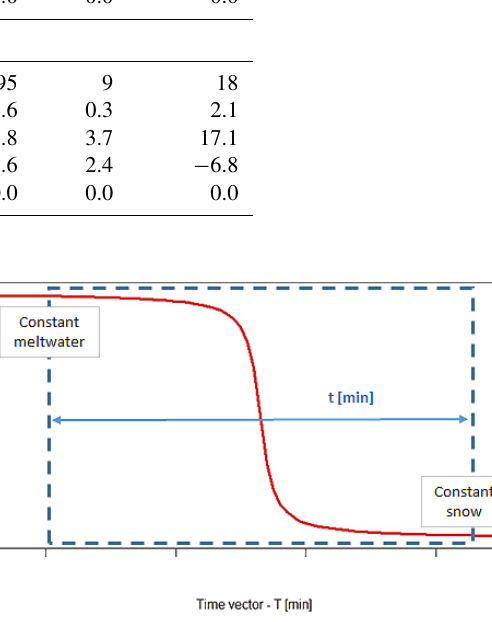
Figure 2. Generalized mixing curve of non-rain water c non-rain (t) representing a transition from the deuterium signature of pre- experimental LWC to a value which is influenced by additional